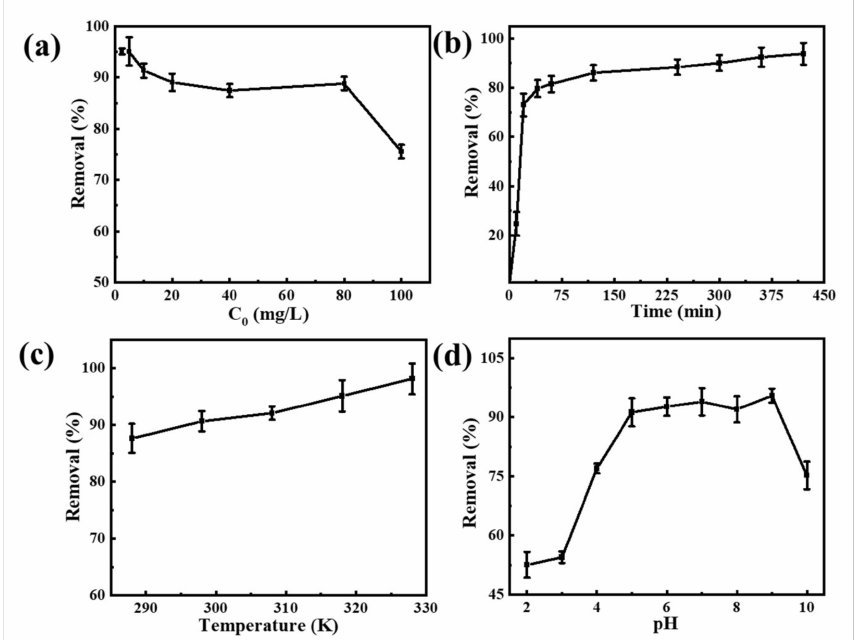
Figure 5. ( a ) Effect of initial concentration on the removal rate of cesium ions by MPBNs (pH = 5.5; m = 30 mg; V = 40 mL; T = 293 K; t = 12 h); ( b ) effect of adsorption time on the removal of cesium ions by MPBNs (C 0 = 40 mg/L; pH = 5.5; m = 30 mg; V = 20 mL; T = 293 K); ( c ) effect of temperature on the removal of cesium ions by MPBNs (C 0 = 40 mg/L; pH = 5.5; m = 30 mg; V = 20 mL; t = 12 h); ( d ) effect of pH on the removal rate of cesium ions by MPBNs (C 0 = 40 mg/L; T = 293 K; m = 30 mg; V = 40 mL; t = 12